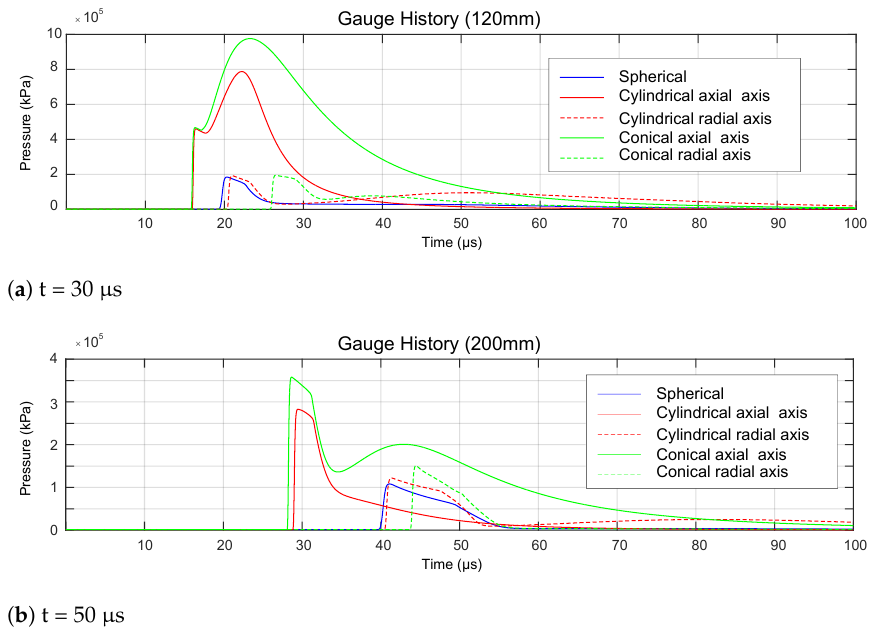
Figure 13. Incident peak pressure histories for 150 g of pentolite.